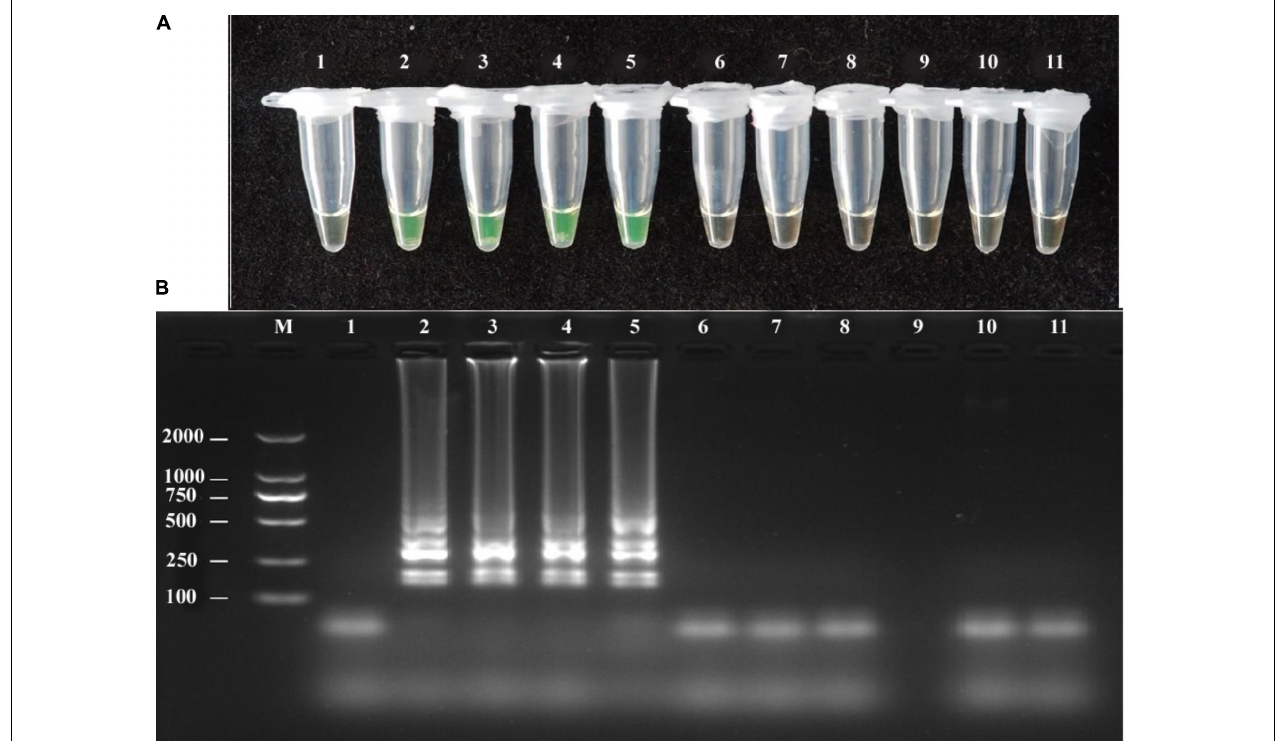
FIGURE 2 | Specificity of LAMP detection of A. solani . Assessment was based on (A) Calcein visualization of color change and (B) agarose gel electrophoresis analysis of the LAMP products. Lane 1: negative control; Lane 2–5: A. solani from different geographic areas; Lane 6: A. longipes ; Lane 7: A. zinniae ; Lane